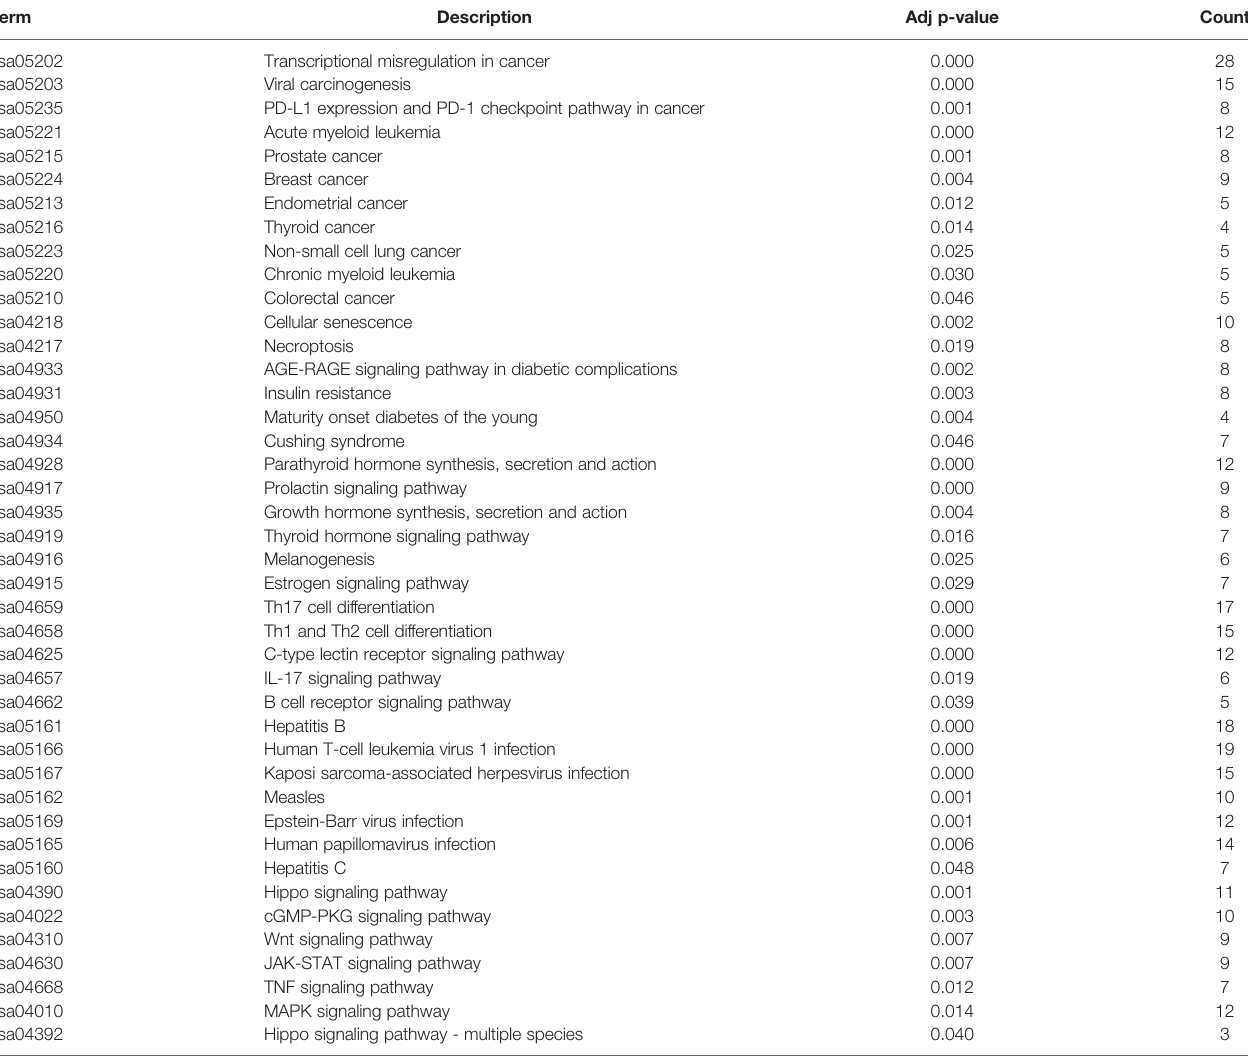
TABLE 4 | KEGG enrichment analysis of